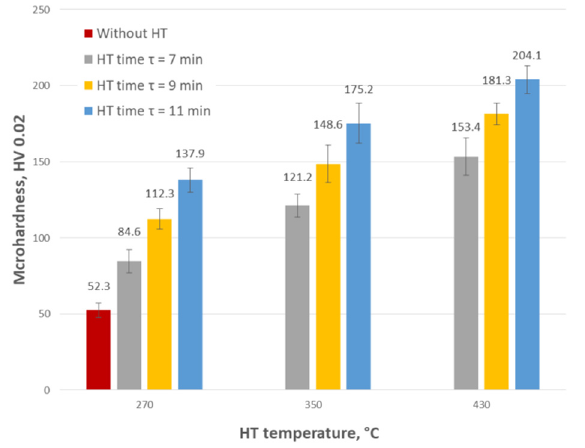
Figure 1. Comparison of the microhardness of zinc coatings measured on bolts surface before and after heat treatment.